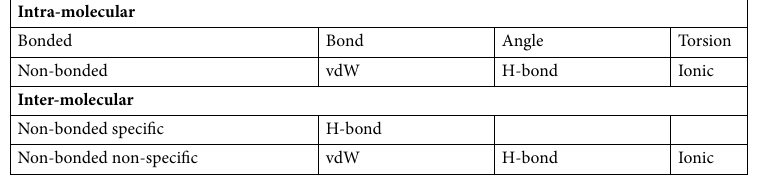
Table 1. Types of protein-DNA interactions. Non-bonded Specific refers to interactions between Amino Acid (AA) and DNA bases and Non-bonded Non-specific refers to interactions between AA and DNA